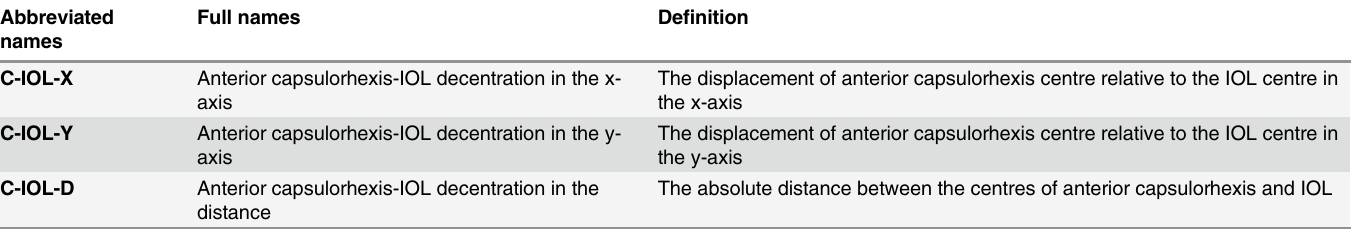
Table 4. Parameters definition of anterior capsulorhexis-IOL position after three-dimensional (3-D) construction of anterior segment.